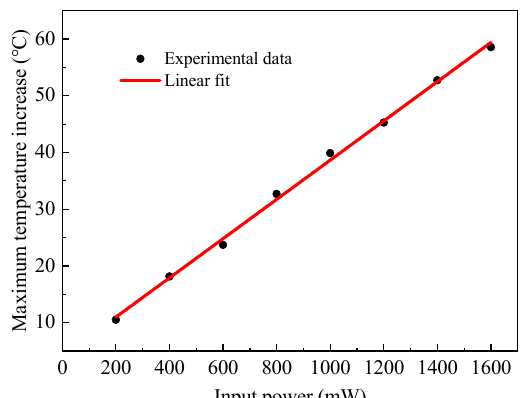
Figure 3. The maximum temperature change in the sensing fiber vs. input power of the HAF.